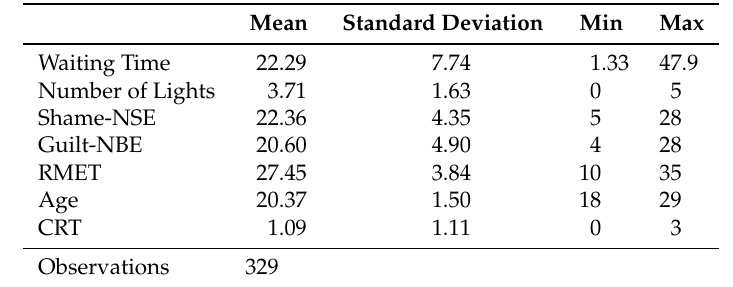
Table 2. Summary statistics.